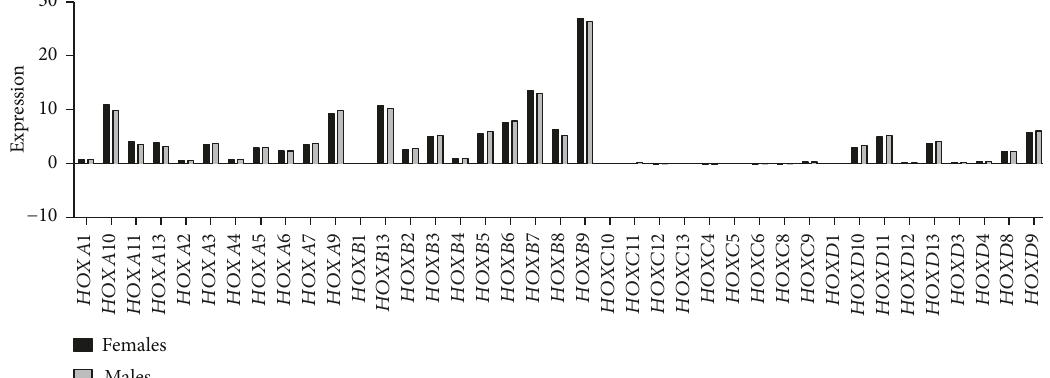
Figure 5: Gender-based HOX gene expression in CRC. The Cancer Genome Atlas (TCGA) was used to analyze gender-based di ff erences in HOX gene expression in CRC patients. Normalized FPKM expression of HOX genes is plotted for male versus female CRC